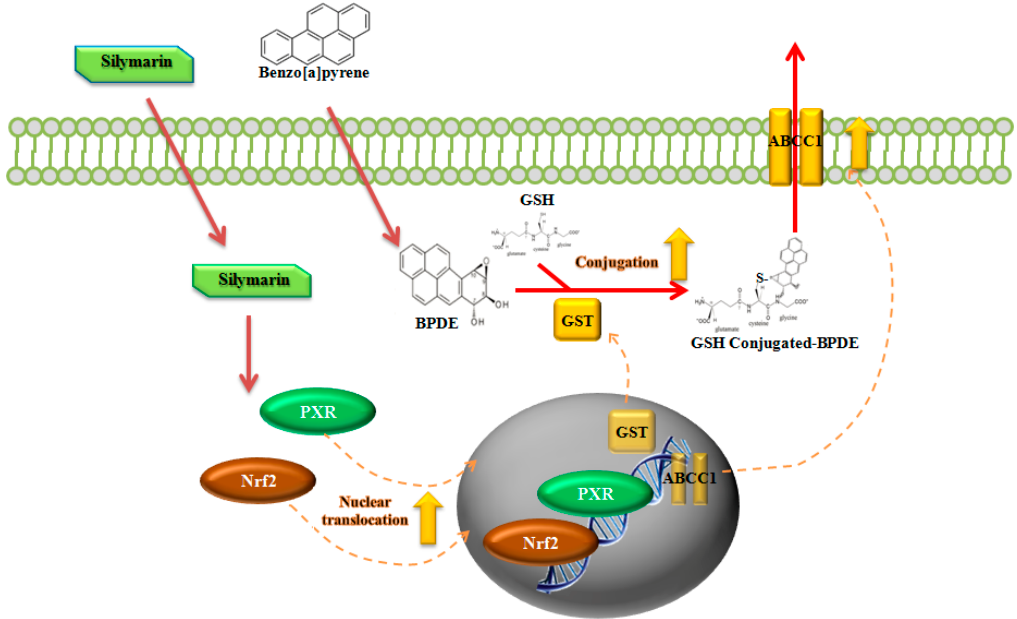
Figure 6. Schematic of reduction of B[a]P-induced genotoxicity by silymarin through Nrf2 and PXR. Silymarin induces Nrf2 and PXR translocation and can regulate the expression of GSTs and ABCC1, enhancing GSH conjugation with BPDE to facilitate the excretion